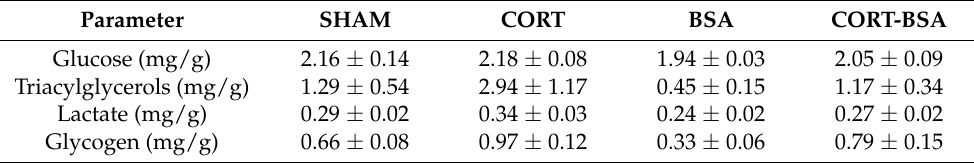
Table 3. Skeletal muscle glucose, triacylglycerols, lactate and glycogen content in vehicle (sham- control), cortisol, BSA and cortisol-BSA administered fish at 72 h post-treatment. Results are ex- pressed as mean ± SEM ( n = 8). Different letters indicate significant differences between groups ( p value < 0.05). All data were analyzed using one-way ANOVA and Tukey’s HSD as a post hoc test. Parameter SHAM CORT BSA